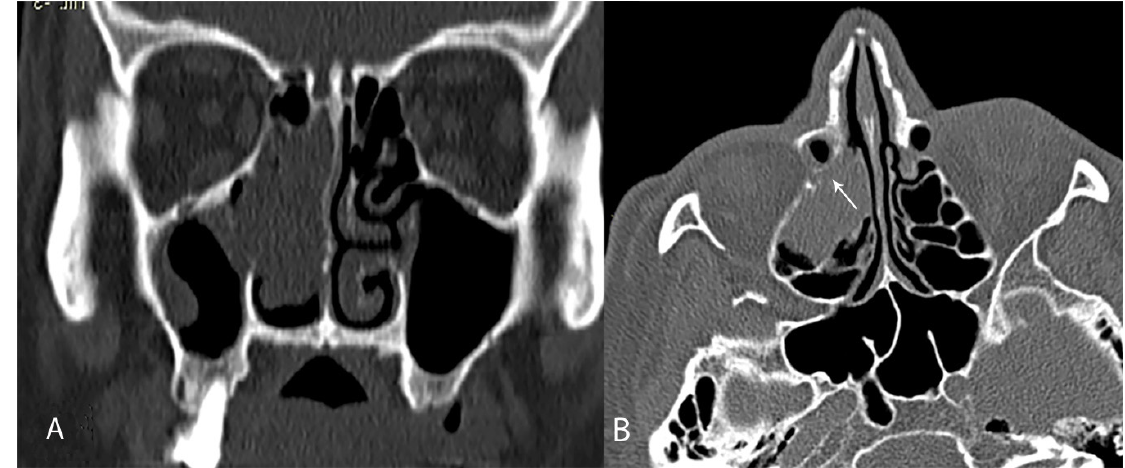
Figure 3. Inverted papilloma of the maxillary sinus. Tumor present in the immediate vicinity of the nasolacrimal duct—arrow, frontal plane ( A ), axial plane ( B ).